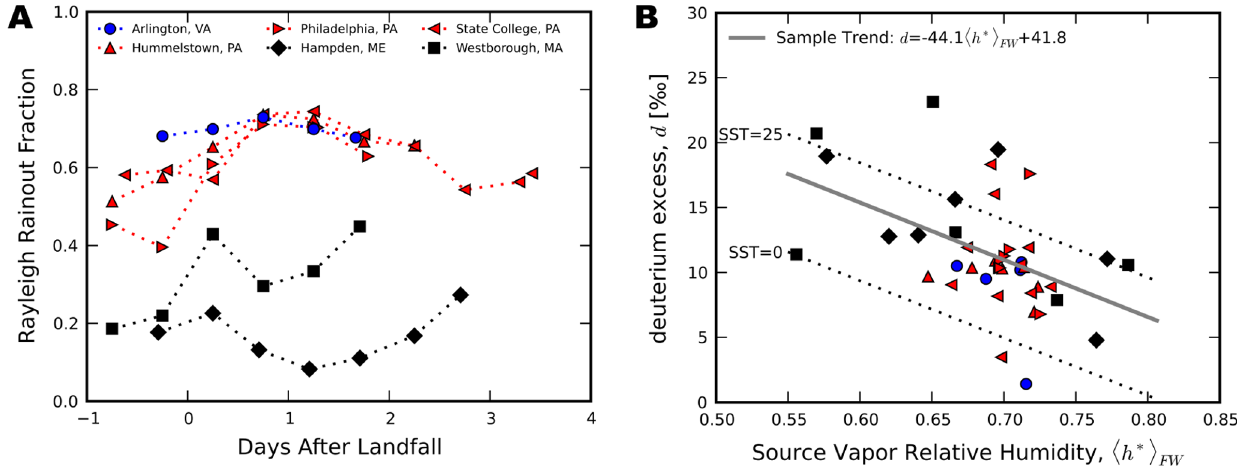
Figure 5. Isotopic signatures of Sandy intensity and interaction with dry continental air. ( A ) Rayleigh rainout fraction at STILT sites based on change in isotopic composition from estimated source moisture to collected precipitation sample. ( B ) Deuterium-excess at STILT trajectory locations and times (symbols) as a function of surface normalized source vapor relative humidity, S h (cid:2) T FW . The linear trend fit to collected samples (gray line) falls between d values expected from vapor with sea surface temperatures (SST) of 0 0 C and 25 0 C (dotted lines). Symbols are the same in A and B and colors match the regions of Figure 2.